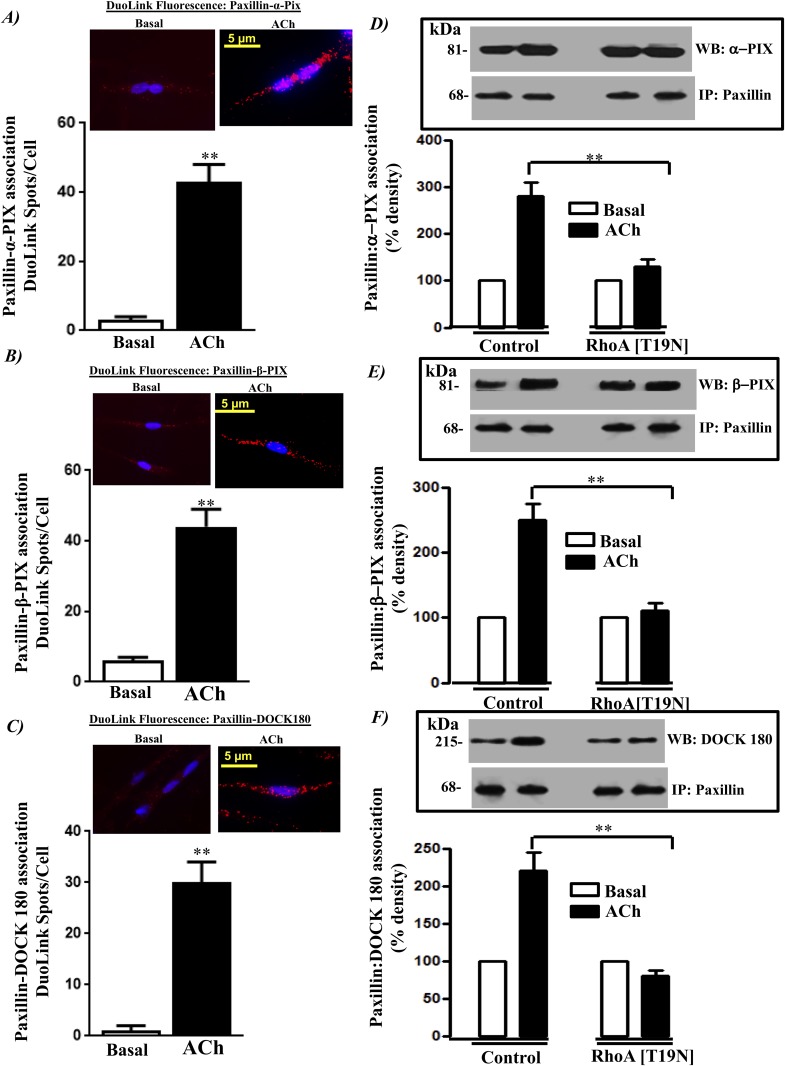
Protein-protein association.Cultured smooth muscle cells expressing either control vector or RhoA dominant negative (RhoA [T19N]) were treated for 10 min with 1 μM ACh. The association of paxillin with α-Pix (A and D), paxillin with β-Pix (B and E), and paxillin with DOCK 180 (C and F) are shown. Immunoprecipitates derived from 100 μg protein using paxillin antibody were separated using SDS-PAGE and immunoblotted using α-Pix, β-Pix and DOCK 180 antibodies. The results are expressed as densitometric values. Values are means ± SE of three experiments. **P<0.001.